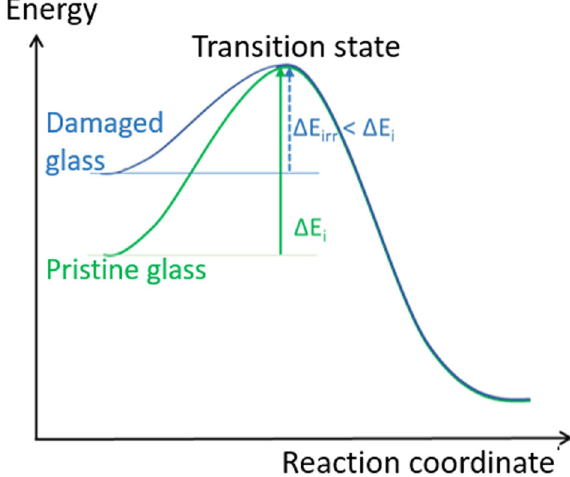
Fig. 6 Schematic of hypothesis 2, which describes energy of system (glass) as a function of reaction coordinate. This implies that the transition states of reactions occurring from the pristine and damaged glasses are